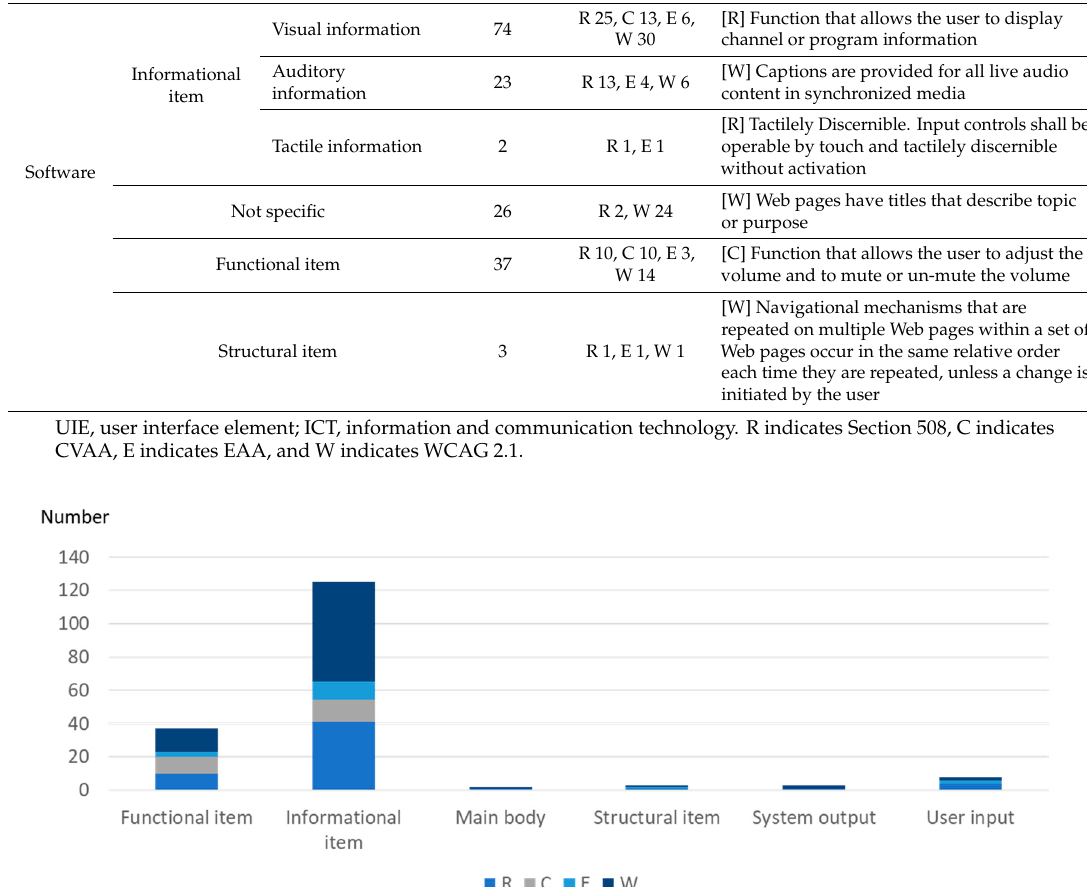
Table 9. Numbers of provisions for each context factor.